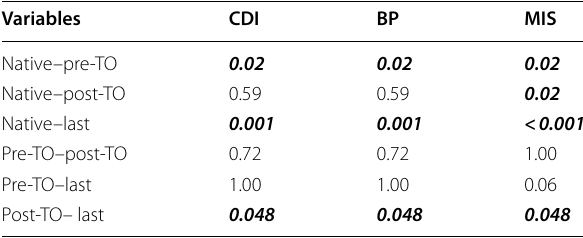
Table 4 Dunn-Bonferroni correction for post-hoc analysis of the radiographic variables